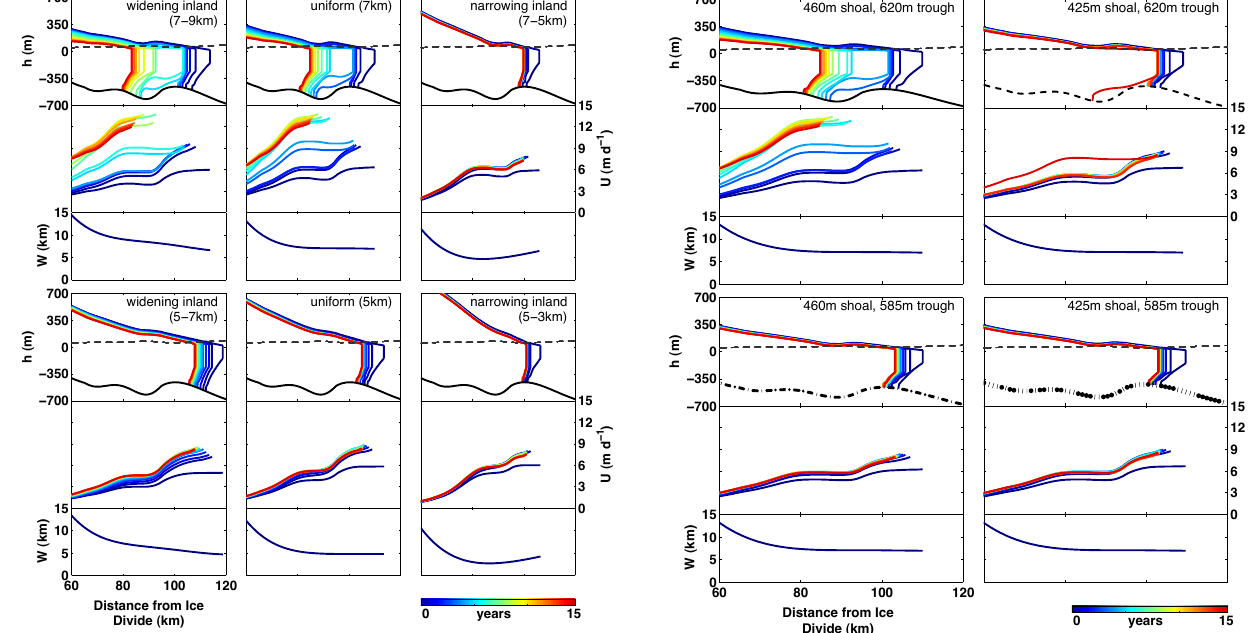
Fig. 3. Modeled annual elevation and speed profiles within the out- let channel (color coded for time, see colorbar) obtained using the 4 bed elevation profiles examined herein for 15yr following the onset of the step perturbation. In the elevation profiles, the thin dashed gray line is the ice surface elevation required to remain